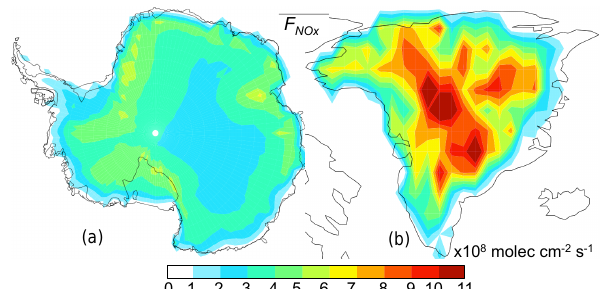
Figure 7. Nitrogen recycling factor (NRF; Eq. ) . x